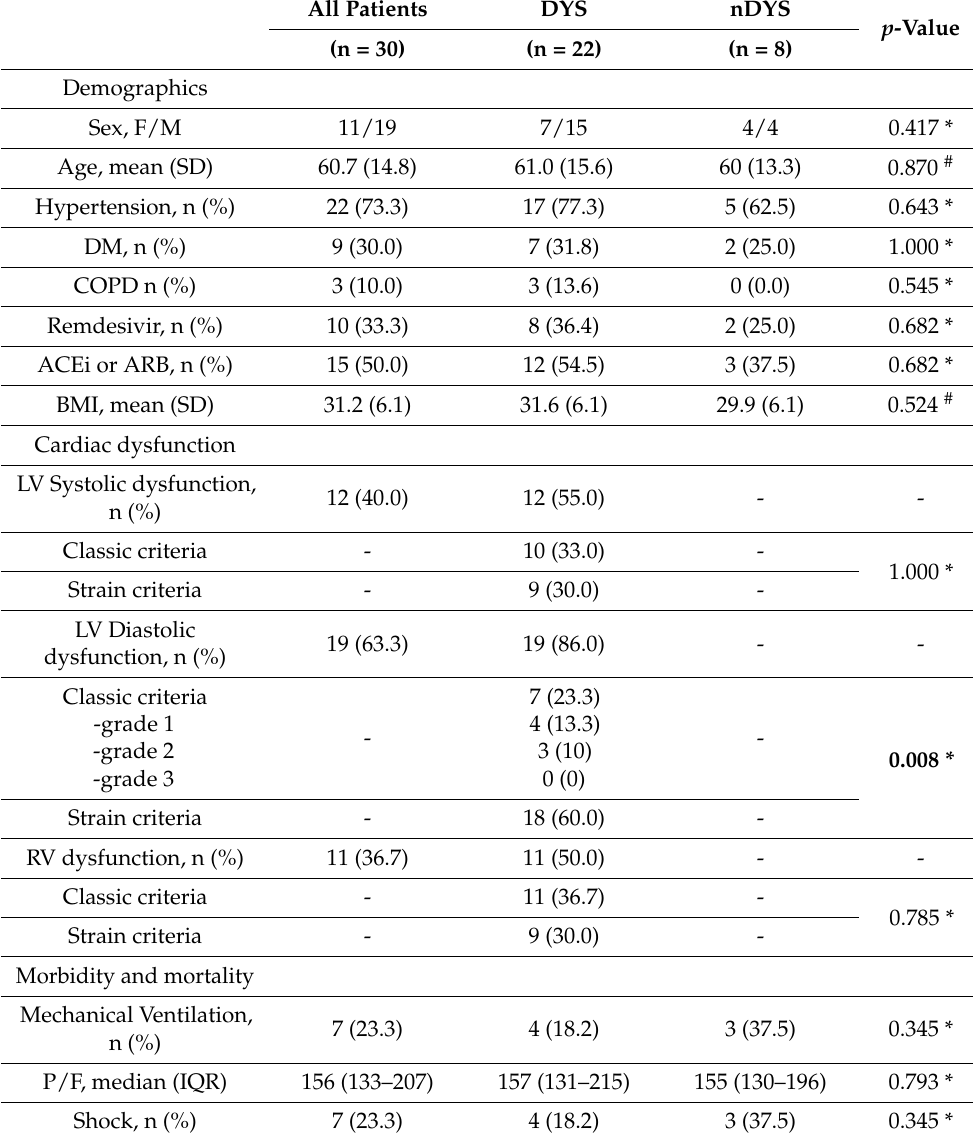
Table 1. Baseline characteristics of patients with (DYS) and without (nDYS) cardiac dysfunction at ICU